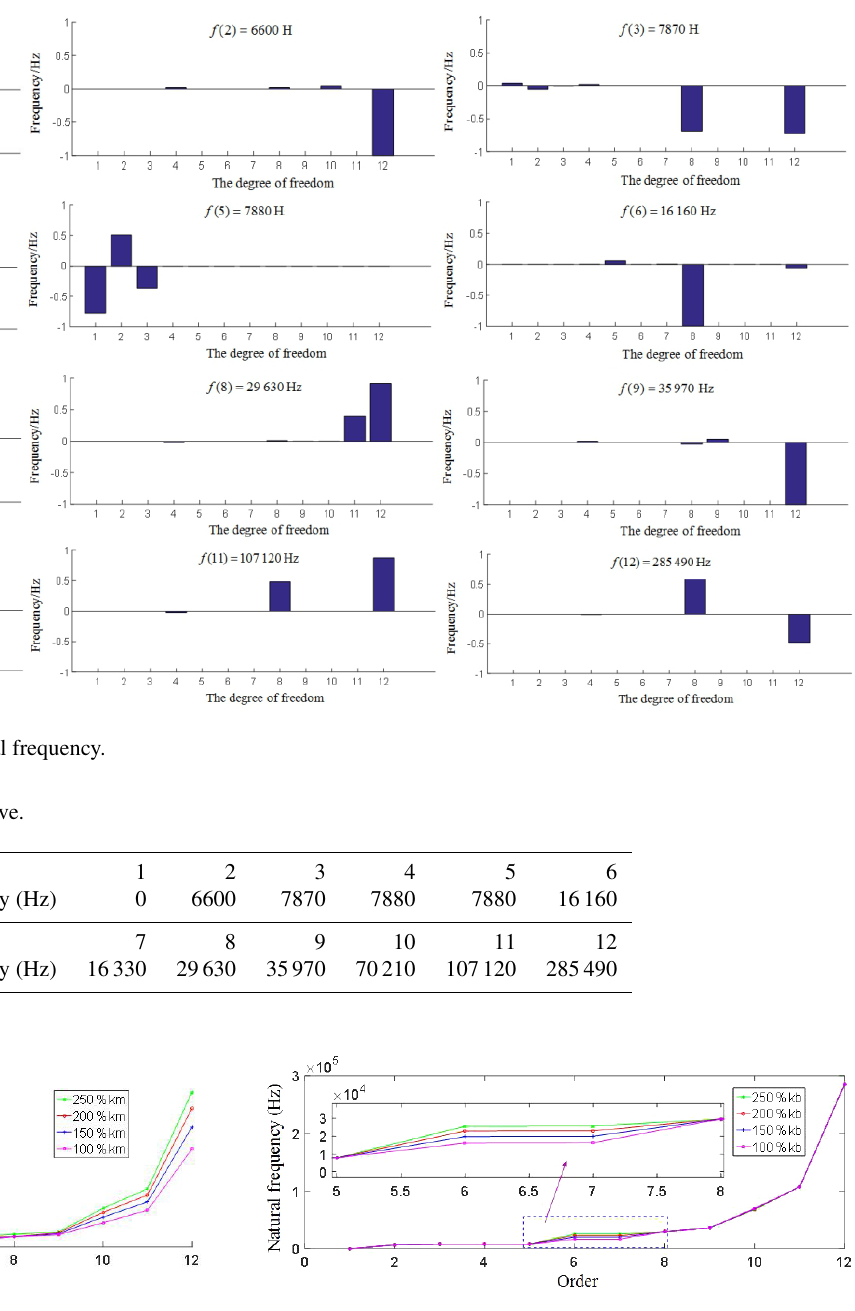
Figure 6. Natural frequency with different bearing support stiffness of nutation